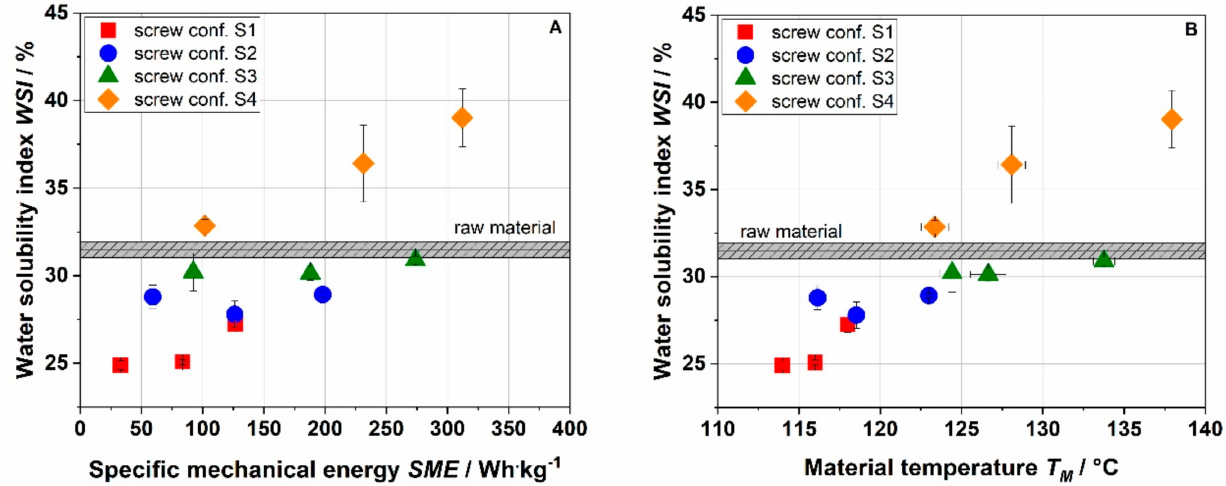
Figure 6. Effect of specific mechanical energy SME ( A ) and material temperature T M ( B ) on water solubility index (WSI) of apple pomace for various screw configurations at a water content of 22%. S1: only transport elements, S2: two reverse elements, S3: four reverse elements, S4: two reverse elements and a kneading